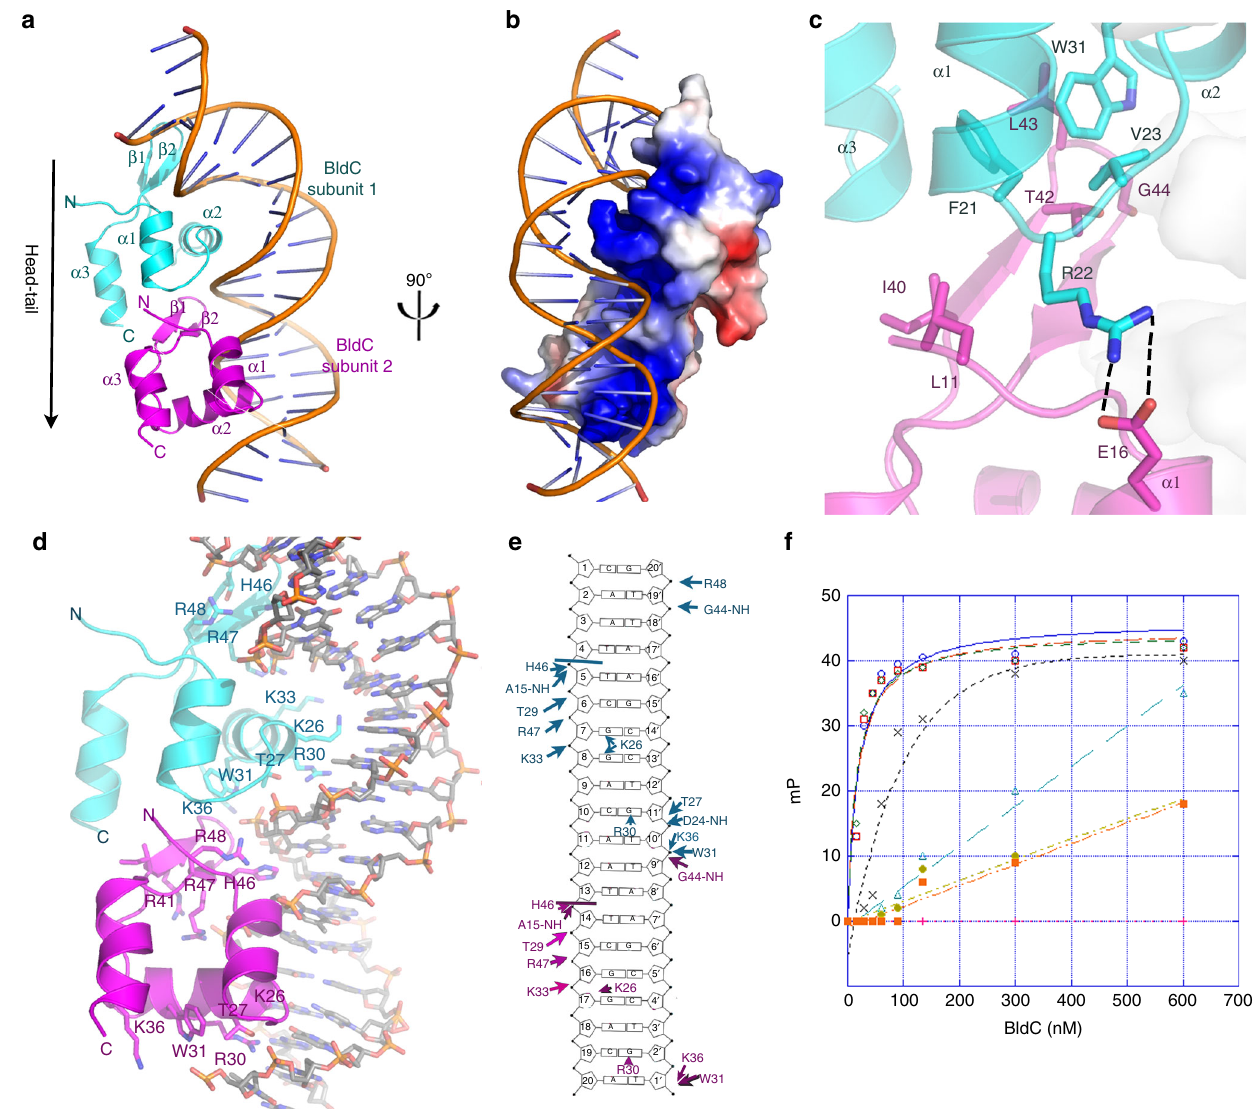
Fig. 4 Structure of the BldC- whiI opt DNA complex. a Overall BldC- whiI opt structure with one BldC subunit colored cyan and the other magenta. The secondary structural elements are labeled. The head-tail directionality of BldC binding is indicated by an arrow. b Electrostatic surface representation of the structure rotated by 90° relative to a . Blue and red represent electropositive and electronegative regions, respectively. c Contacts important in BldC head- tail dimerization on the DNA. The side chains that mediate dimer formation are shown as sticks. The contacts between Arg22 and Glu16 from apposing subunits are shown as dashed lines. d BldC-DNA contacts. Residues that contact the DNA are shown as sticks and labeled. e Schematic ladder diagram showing the contacts between BldC and DNA. Note, for clarity, the 2 bp overhangs that are not contacted by BldC are not included. f FP binding isotherms of various BldC proteins binding to a fl uorescently labeled whiI opt 22mer. Experiments were preformed in technical triplicate and the error between measurements noted. Shown are representative binding isotherms for WT His 6 -BldC (red squares), His 6 -Semet BldC(L43M-L58M) (green diamonds), Tag-free WT BldC (blue circles), His 6 -BldC(E16R) (black crosses), His 6 -BldC(G44E) (orange squares), His 6 -BldC(H46A) (light blue triangles) and His 6 - BldC(R30A) (yellow diamonds). The resulting K d s for these curves are 18.2 nM ± 4.8 nM, 19.6 nM ± 4.8 nM, 16.5 nM ± 4.0 nM, 140 nM ± 63 nM, no saturable binding (NB), NB and NB, respectively. The y -axis and x -axis are mP and BldC concentration (nM),